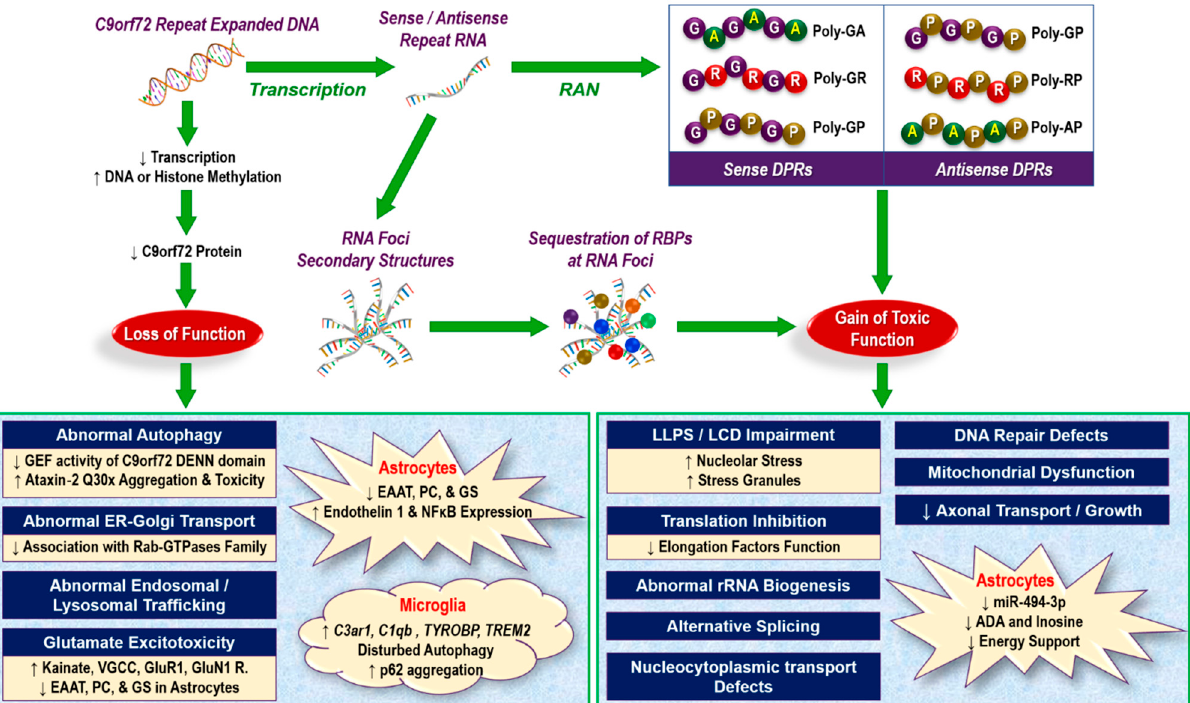
Figure 3. Pathogenic mechanisms implicated in C9orf72 ALS/FTD. Both loss and gain of function mechanisms contribute to the disease process in C9orf72 ALS/FTD. Abbreviations: ADA, adenosine deaminase; C1qb, complement component 1, Q subcomponent, β polypeptide; C3ar1, complement component 3a receptor 1; DENN, differentially expressed in normal and neoplastic cells; EAAT, excitatory amino-acid transporter; GEF, GEF, guanine nucleotide exchange factor; GluN1 R, glutamate ionotropic receptor NMDA type subunit 1; GluR1, glutamate ionotropic receptor AMPA type subunit 1; GS, glutamine synthetase; LCD, low complexity domain; LLPS, liquid–liquid phase separation; miRNA, microRNA; PC, pyruvate carboxylase; rRNA, ribosomal RNA; TREM2, triggering receptor expressed on myeloid Cells 2; TYROBP, tyrosine kinase binding protein; and VGCC, voltage-gated calcium channel.